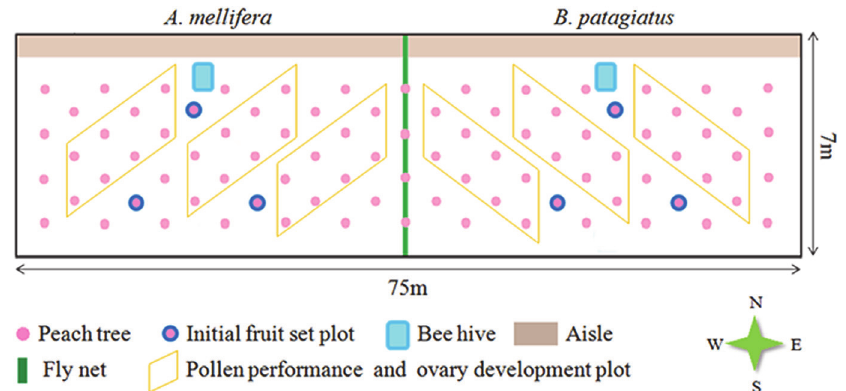
Fig 1. Layout of sampling plots of peach trees in